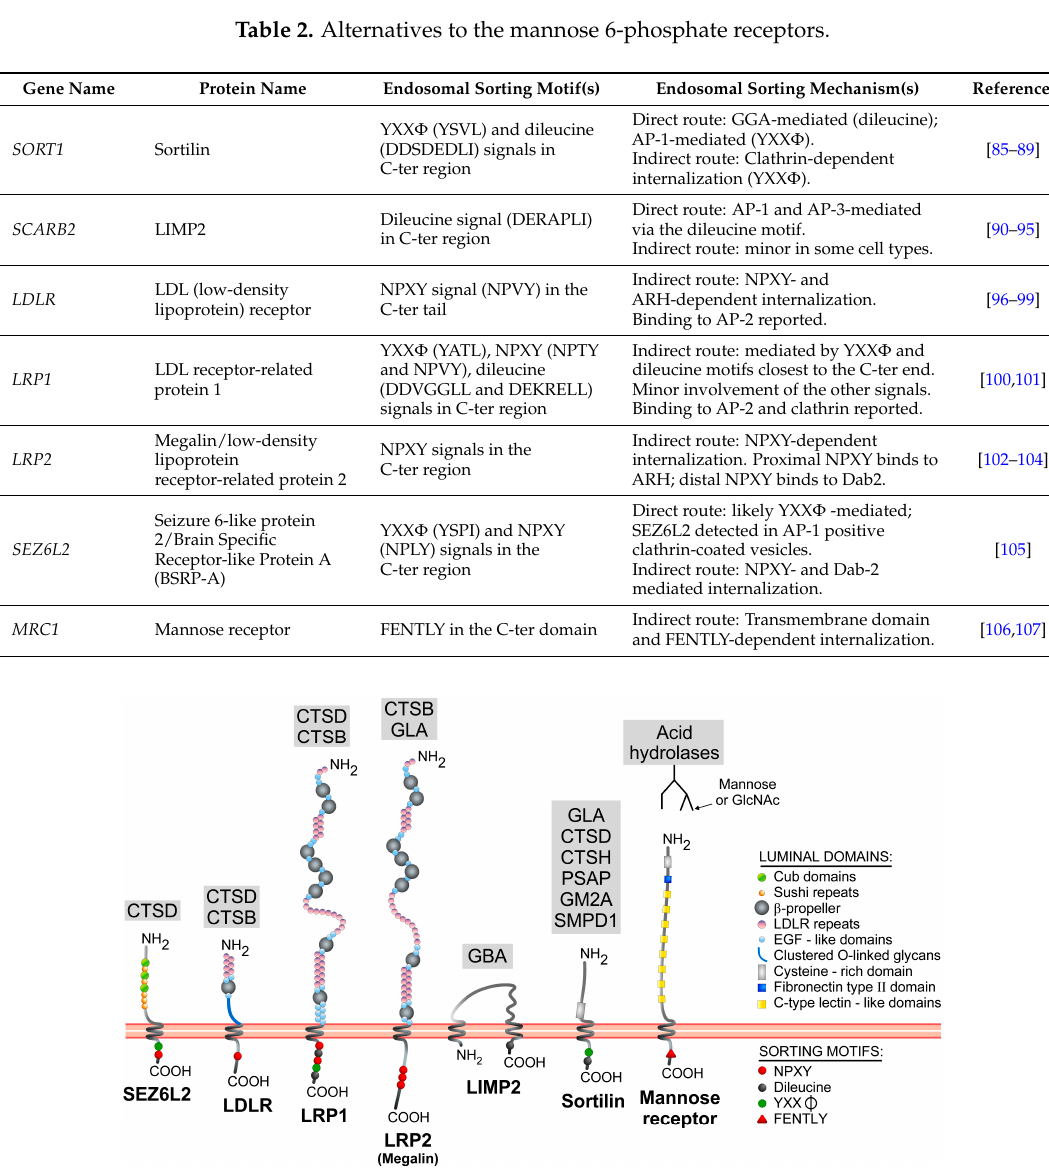
Figure 1. Structure and lysosomal cargo(es) of Man-6-P-alternative receptors. These receptors are mostly type I transmembrane proteins, with the exception of LIMP2, which is type III transmembrane protein. Luminal domains/repeats, and known cytosolic sorting signals are indicated on the scheme. The lysosomal proteins that bind to these receptors are listed in the grey boxes. CTSB: cathepsin B; CTSD: cathepsin D; CTSH: cathepsin H; GLA: α -galactosidase; GBA: β -glucocerebrosidase;